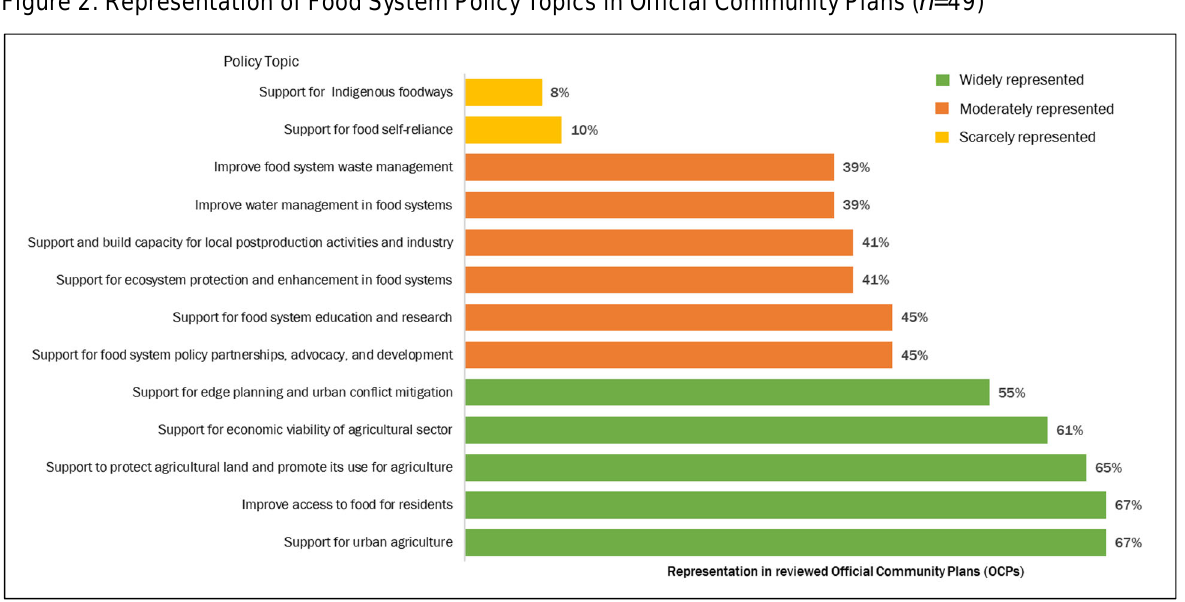
Figure 2. Representation of Food System Policy Topics in Official Community Plans ( n